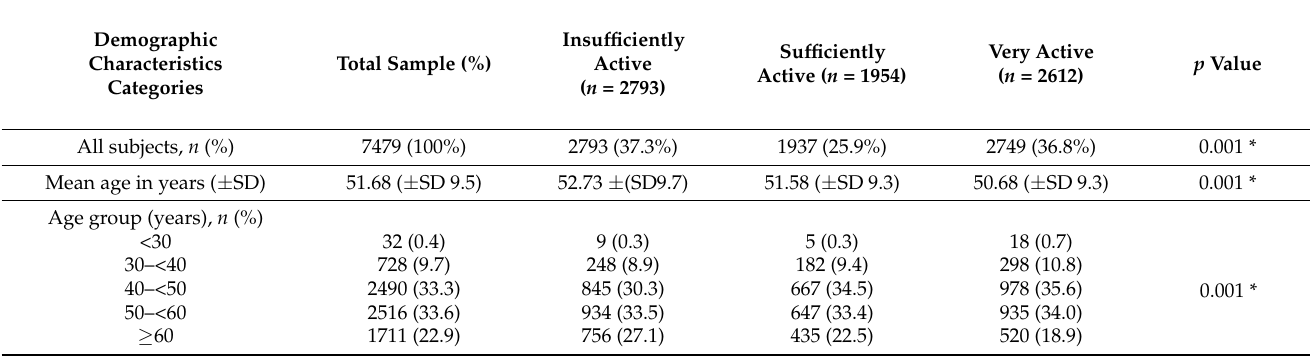
Table 1. The socio-demographic and clinical characteristics of the participants within the physical activity levels (insufficiently active, sufficiently active, very